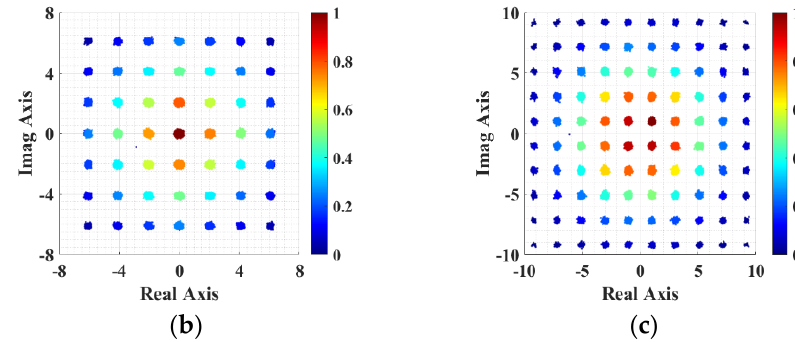
Figure 3. The PDF of n-level polybinary transformation for 16QAM signal: ( a ) 1-level polybinary transformation of original signal; ( b ) duobinary transformation; ( c ) tribinary transformation.